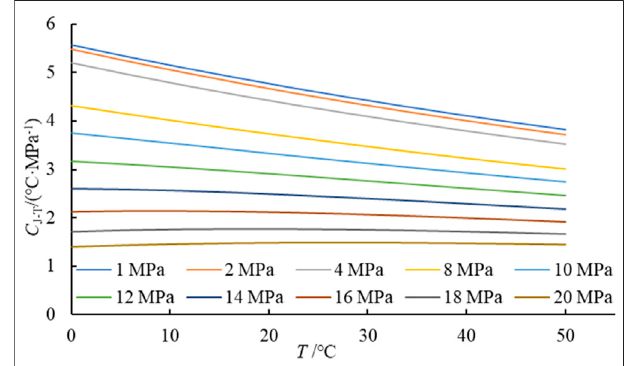
FIGURE 2 | Reference values of J-T coef fi cients under different temperature and